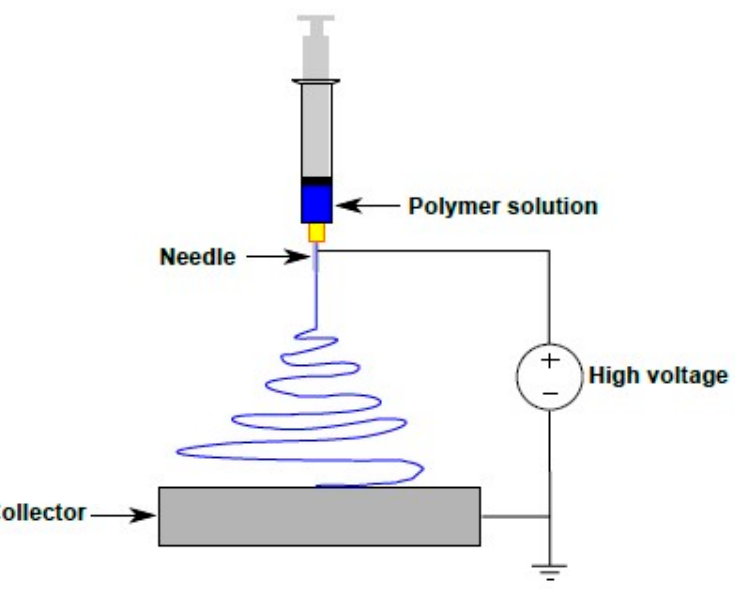
Figure 1. Schematic illustration of far field electrospinning process.